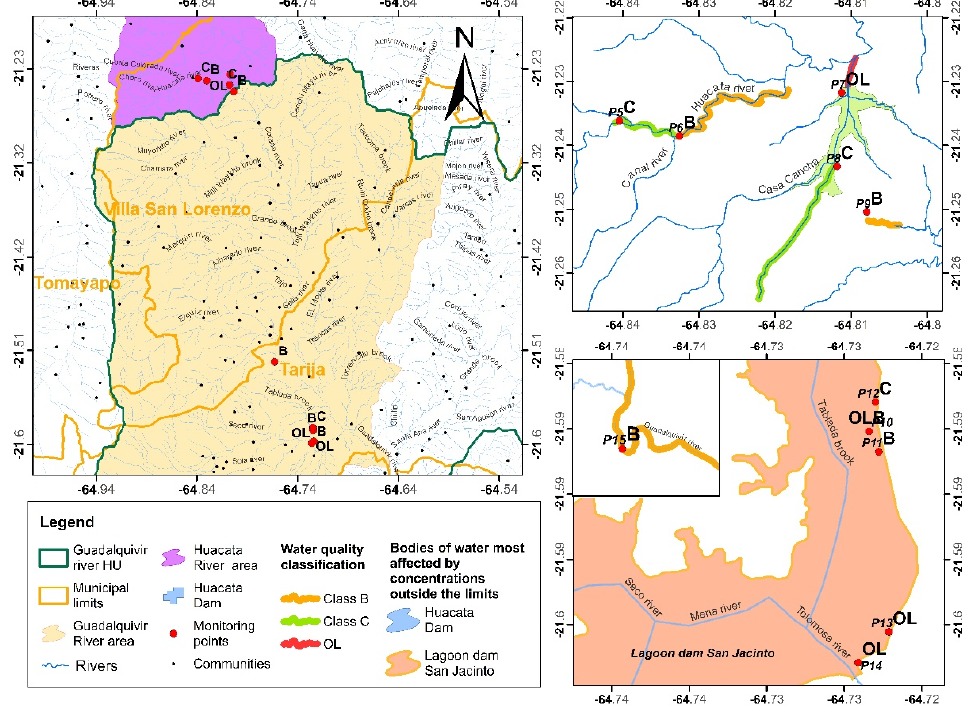
Figure 13. Vulnerable areas to the concentration of heavy metals in Guadalquivir. Table 1. Health effects of heavy